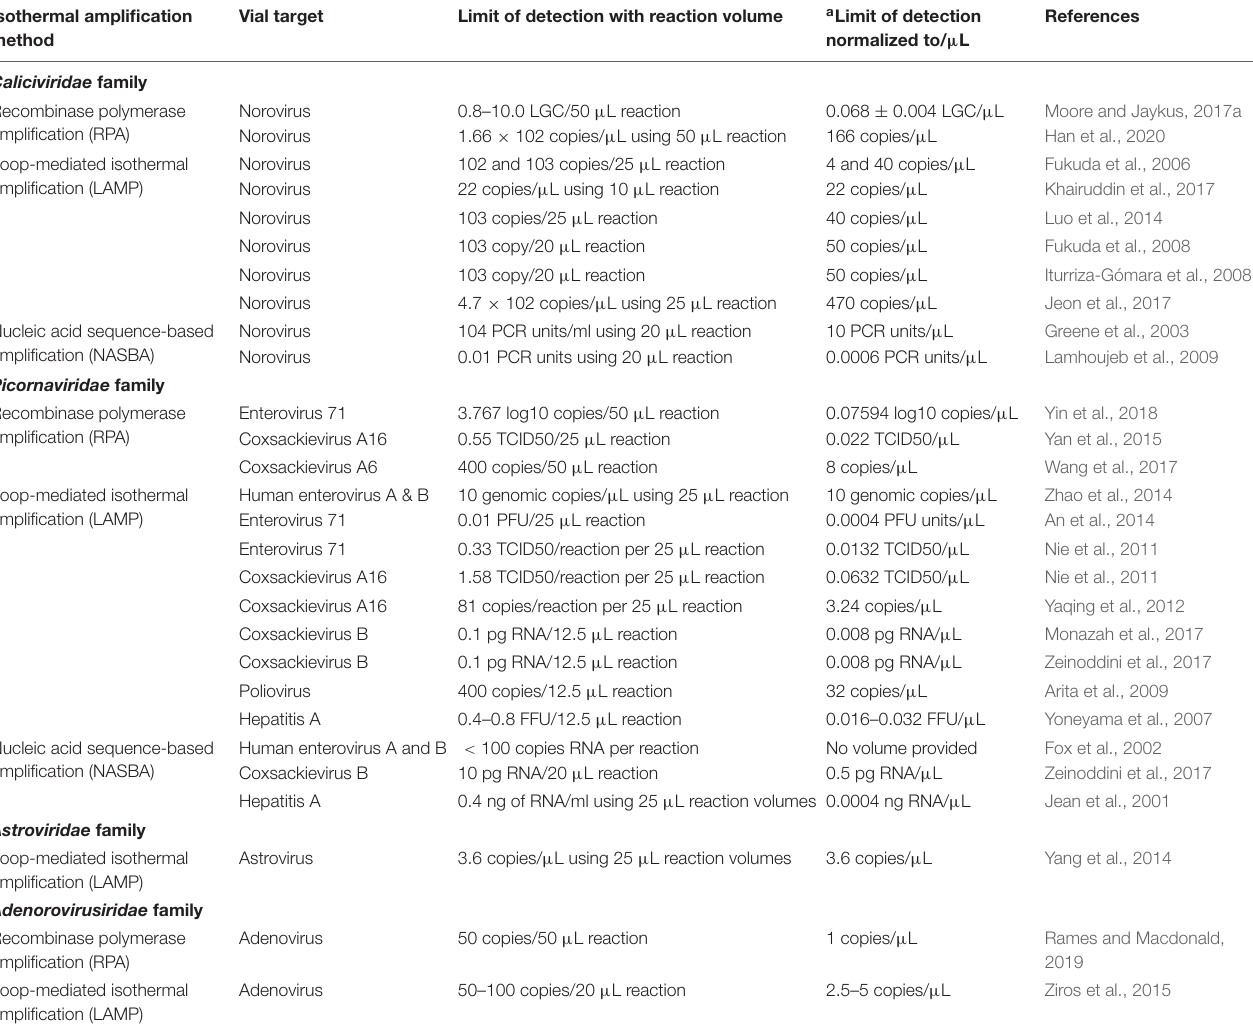
TABLE 1 | Comparison of limits of detection observed for different isothermal assays developed against foodborne and enteric